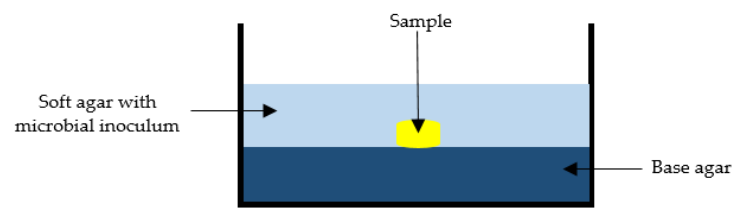
Figure 9. Schematic representation of bacterial overlay assay.